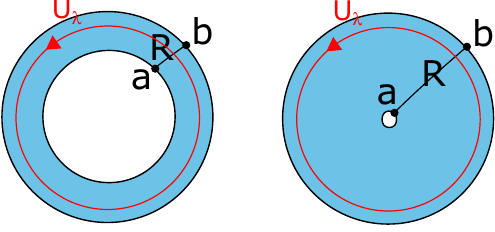
Figure 8 . Left: annulus. Right: closing of the inner hole to form a